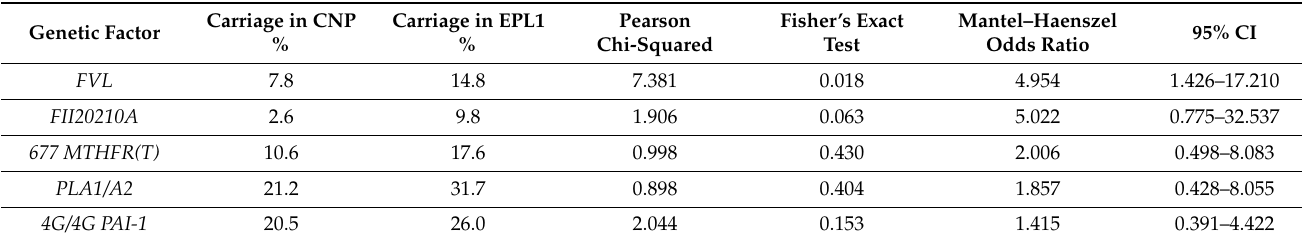
Table 2. Carriage of thrombophilia polymorphisms FVL, FII20210A, 677 MTHFR, PLA1/A2, or 4G/4GPAI-1 calculated in percentage for 82 healthy non-pregnant controls (CNP) and the EPL1 group. Chi-Squared, Fisher’s Exact Test, Odds Ratio, 95% CI, and Fisher’s Exact Test values are